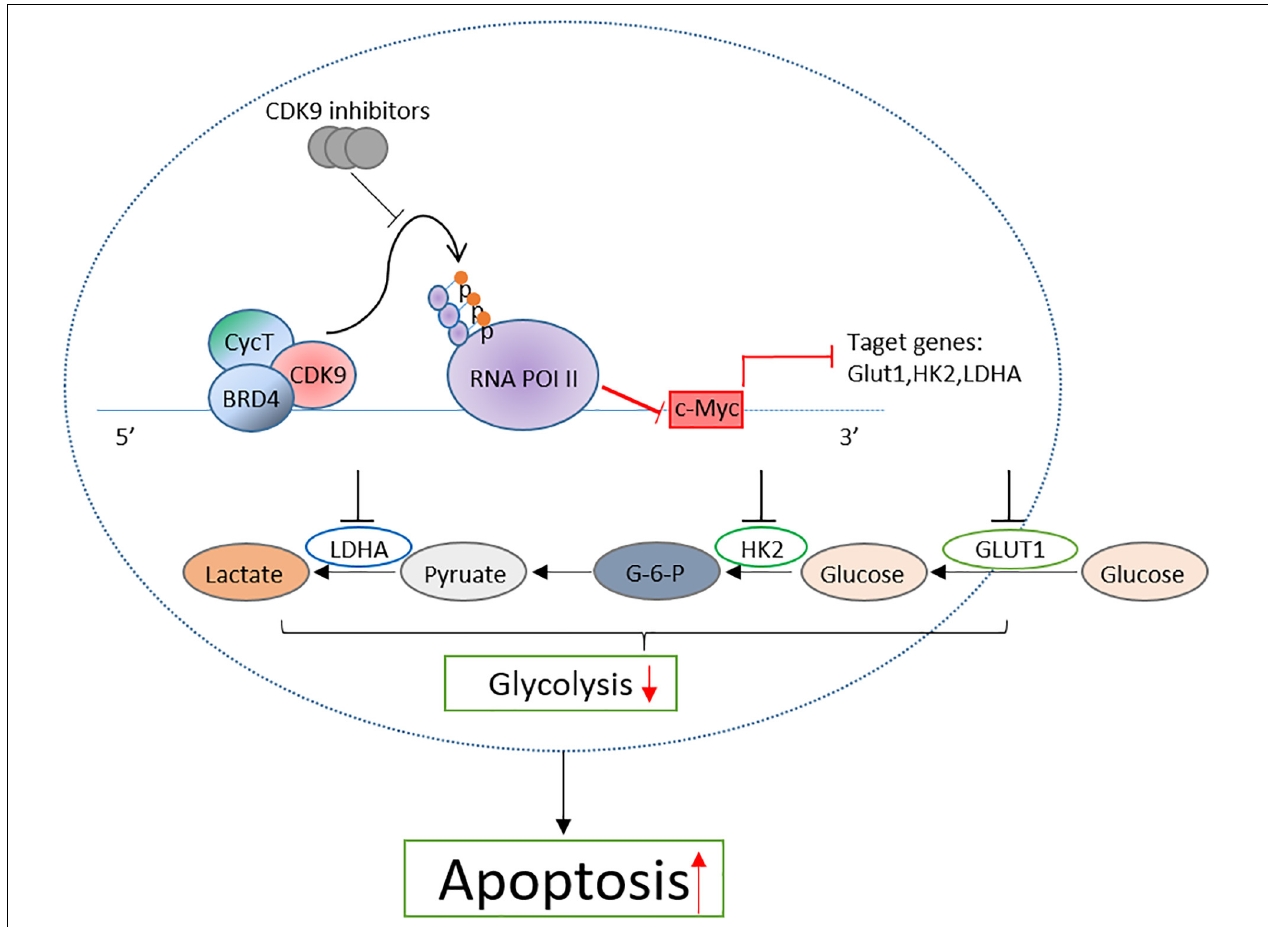
FIGURE 7 | Proposal model of CDK inhibition induced the apoptosis of B-ALL cells by suppressing c-Myc mediated